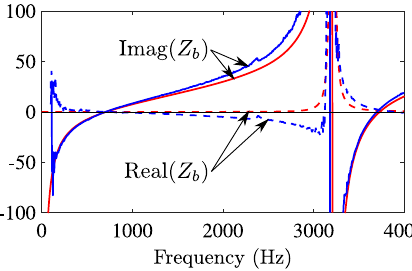
Figure 8. Impedance of the beam Z b deduced from the laser vibrometer measurements. The blue curves are the measure- ments and the red ones correspond to the fi t described in the text.